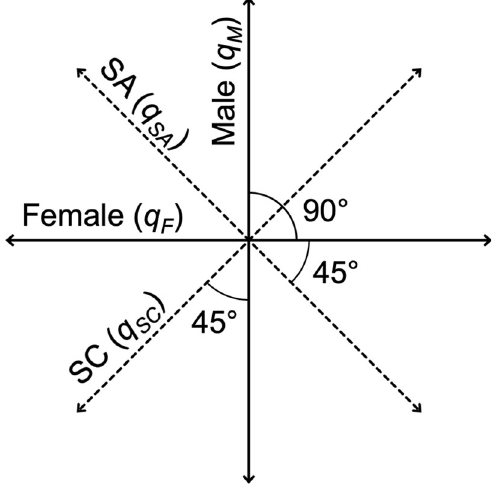
Fig 1. Geometric definition of terms and concepts. For a given inheritance class Q (e.g., additivity, dominance, epistasis, etc.; see below), the BLUPs for each strain’s male- ( q M ) and female-specific ( q F ) variance components from models that were fit separately to male and female data sets represent axes of variation that can be plotted in a bivariate relationship (solid lines). These coordinate systems can be rotated 45˚ (see Materials and methods) to derive the SA ( q SA ) and SC ( q SC ) dimensions (dashed lines) for each inheritance class. BLUP, best linear unbiased prediction; SA, sexually antagonistic; SC, sexually concordant.